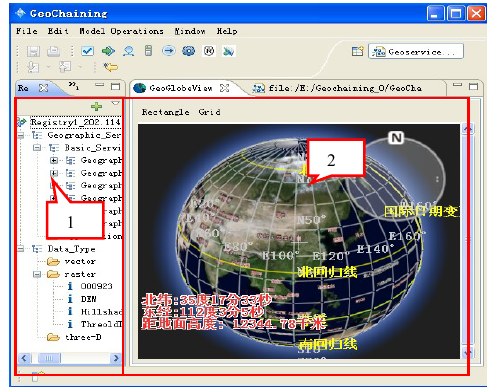
Figure 2. The GUI of registry client and data